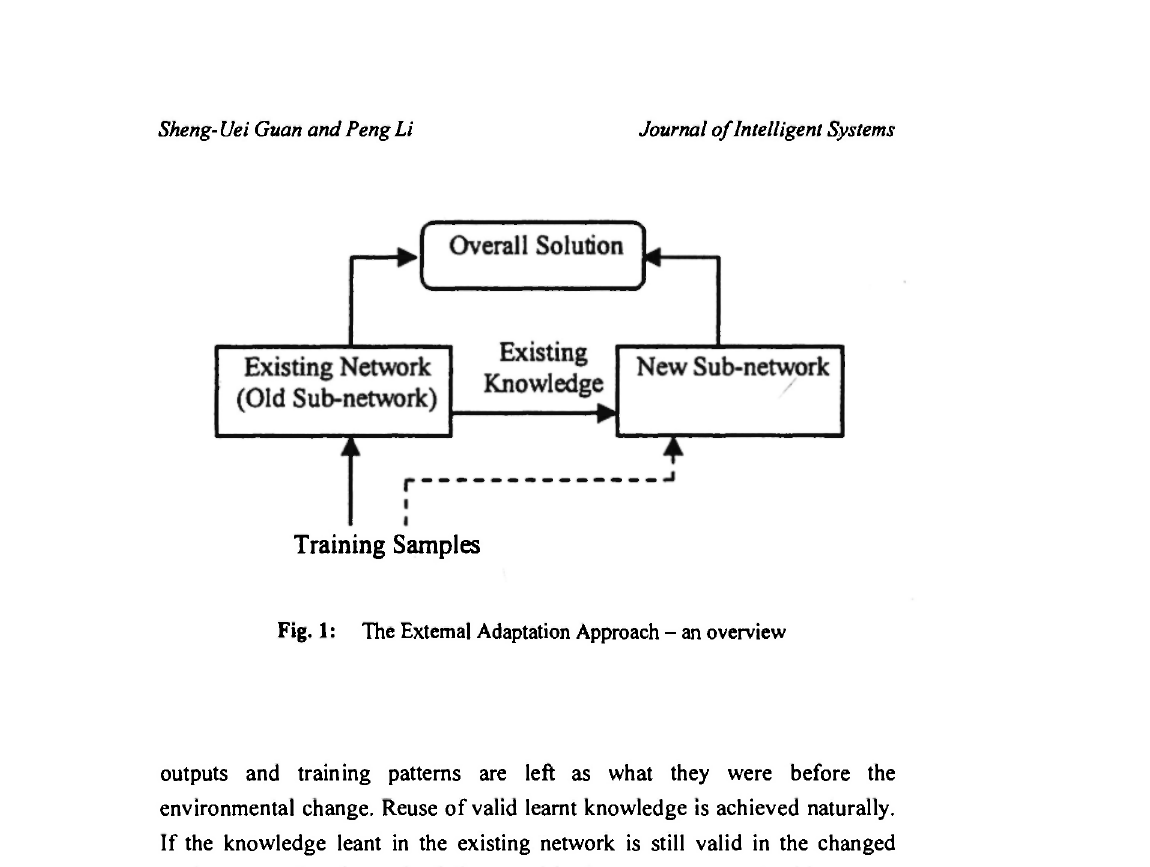
outputs and training patterns are left as what they were before